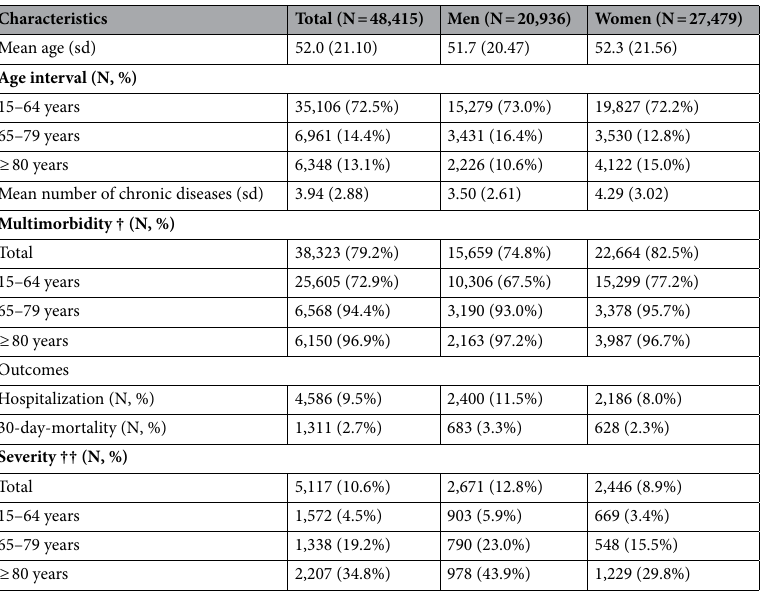
Table 1. Demographic and clinical characteristics of individuals aged 15 years or older with COVID-19 infection in the PRECOVID Cohort. † Multimorbidity, defined as the simultaneous co-existence of two or more chronic diseases, excluding COVID-19; sd, standard deviation; †† Severity, defined as a composite outcome based on the need for hospital admission (including in Intensive Care Units) or 30-day all-cause